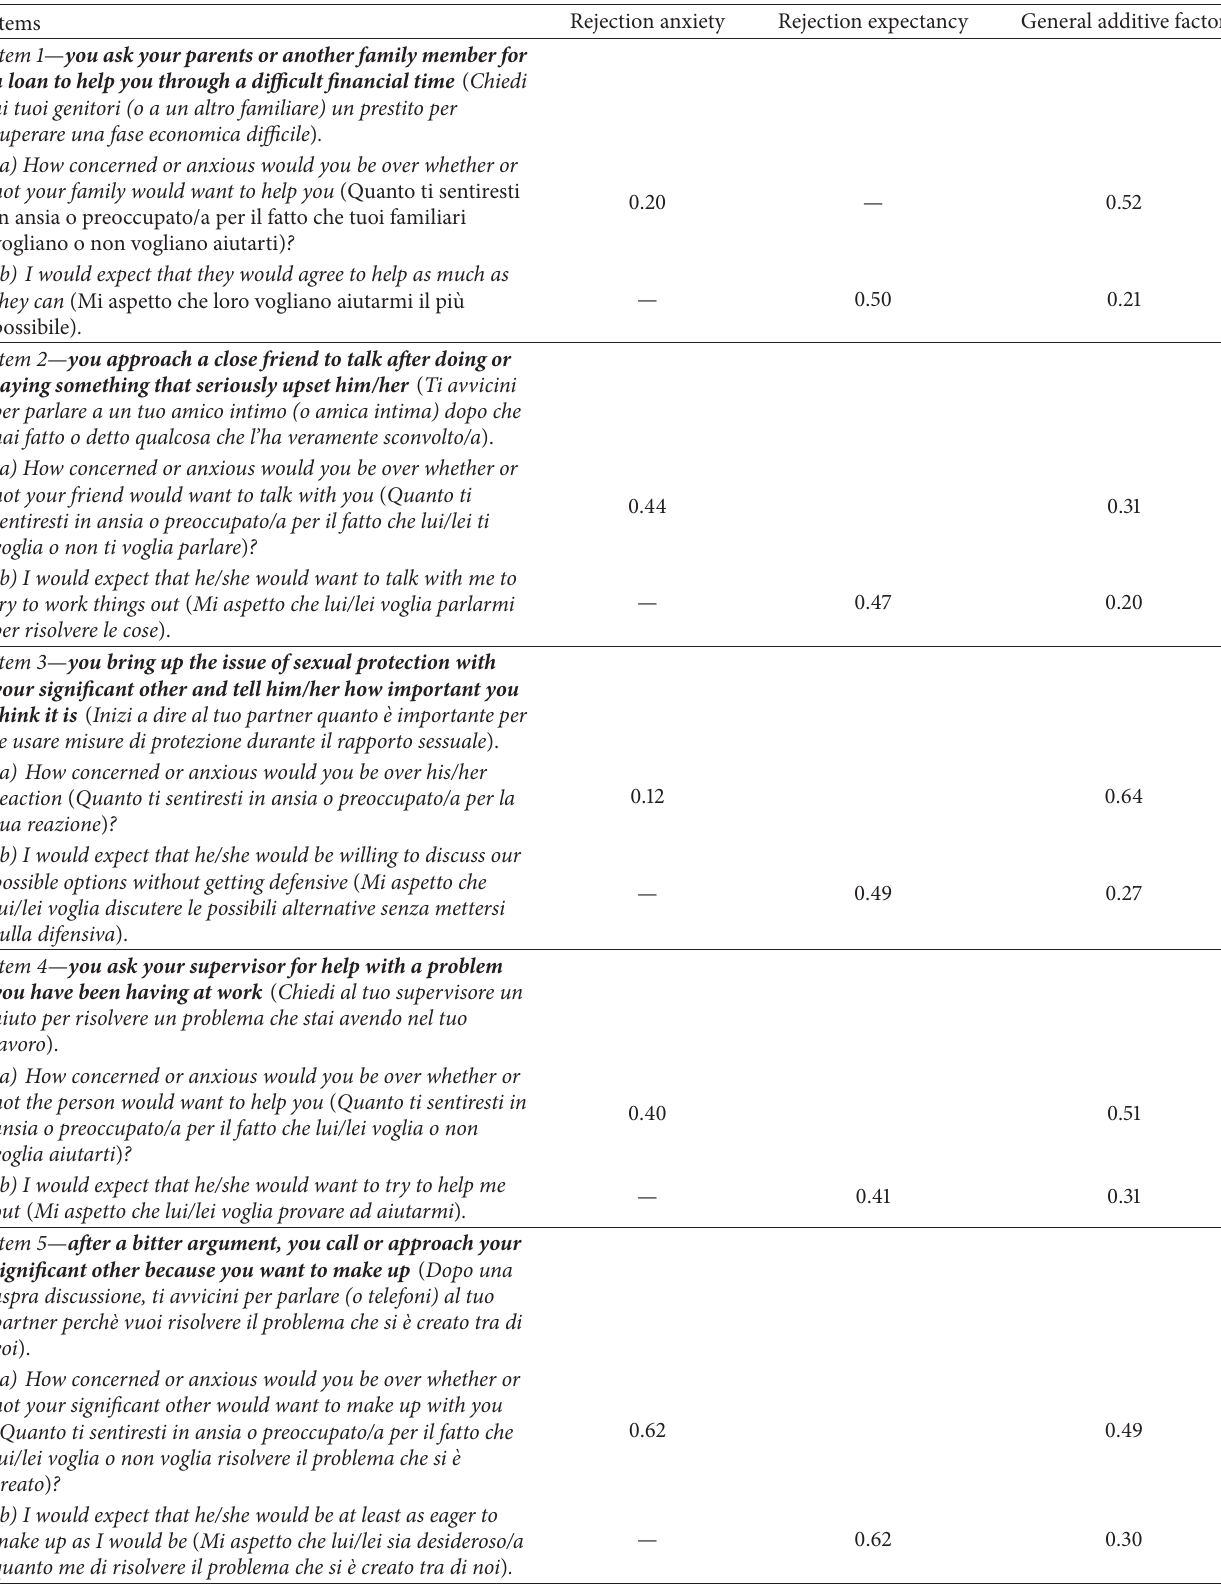
Table 3: Standardized factor loadings (measurement errors) for the bifactor